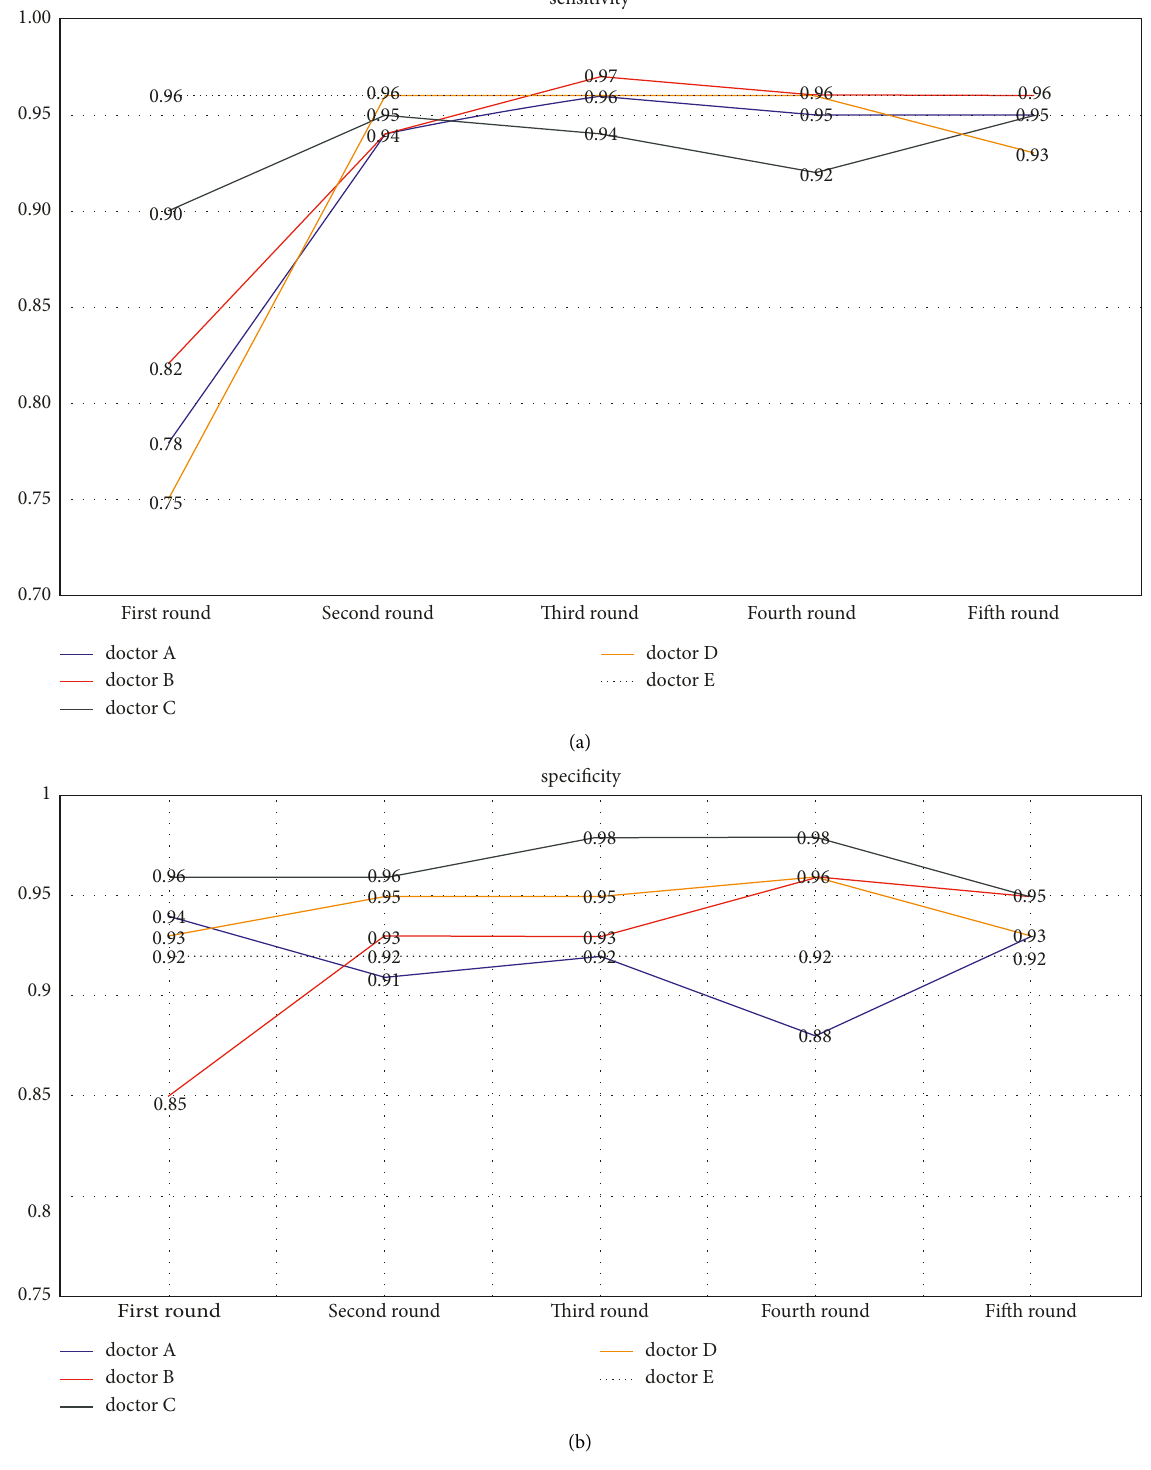
Figure 5: (a) The sensitivity of the four doctors in the first round was lower than that of AI. In the second and third round, the sensitivity of doctors was significantly improved. Among them, the sensitivity of doctor B exceeded that of AI in the third round. Without the assistance of AI, the sensitivity of doctor C decreased in the fourth round, and the same thing happened for doctor D in the fifth round. (b) In the first round, the specificity of three doctors was higher than that of AI and only doctor B’s was lower than that of AI. In the second and third round, the specificity of doctors did not change much. Besides doctor A, the specificity of three doctors was higher than that of AI. In the fourth and fifth round, there was no significant trend change in specificity. The reason was that doctors had a great grasp of the diagnosis for the late glaucoma. Whether AI was involved or not, this phenomenon did not change